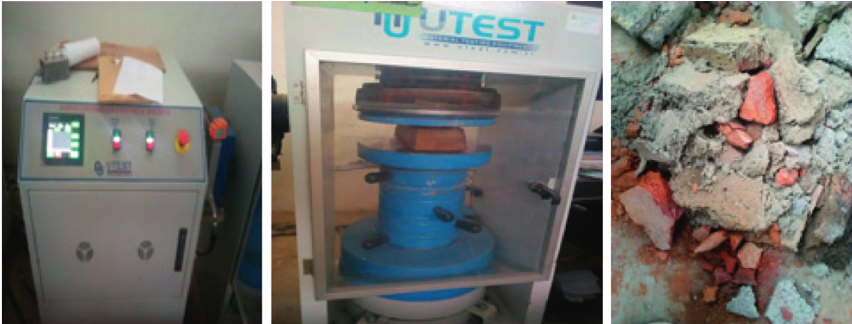
Figure 8: Compressive strength testing of brick. Table 5: Correlation data analysis for compressive strength of brick samples.